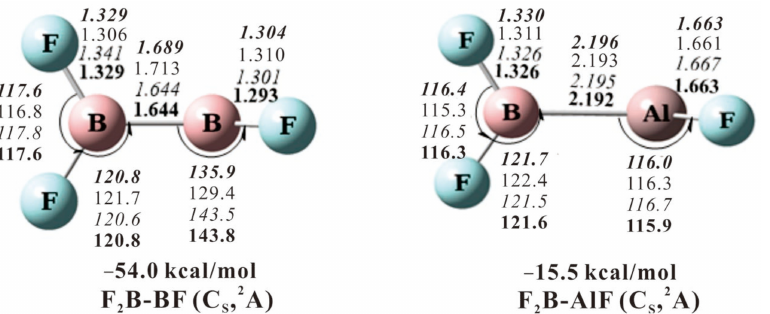
Figure 4. Structures of the product F 2 BMF (M = B, Al) optimized using the CCSD(T)/def2-TZVP(-f) ( bold and italic ), CAS(9e, 11o)/def2-TZVP, BPW91/def2-TZVPP ( italic ) and B3LYP/def2-TZVPP ( bold ) functionals/basis set. The def2-TZVP(-f), def2-TZVP and def2-TZVPP basis are set for all atoms. Bond lengths are in Å and angles in degrees. The energies are in kcal/mol and relative to corresponding M + BF 3 calculated by